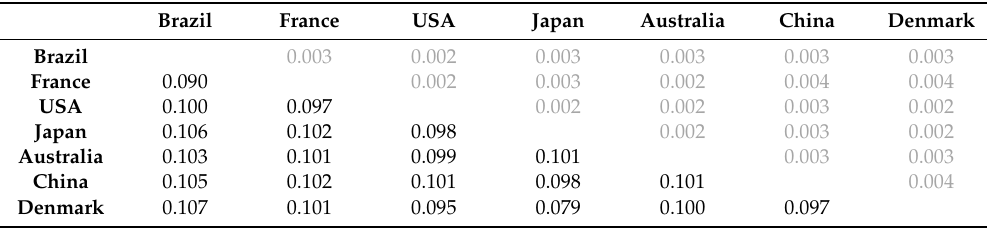
Table 2. Mean genetic distances between groups of full-length HCV subtype 2b sequences from di ff erent geographical